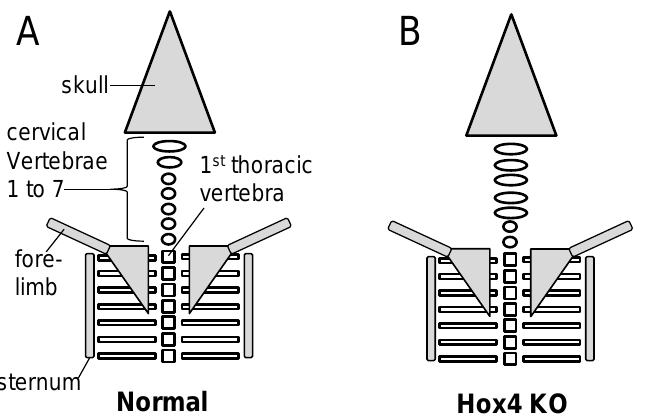
Figure 9. Mouse knockout (KO) anterior skeletal phenotype for Hox4 genes. ( A ) Normal newborn mouse. ( B ) Mouse knocked out for six Hox4 genes (Hoxa4, b4, d4, maternal and paternal).